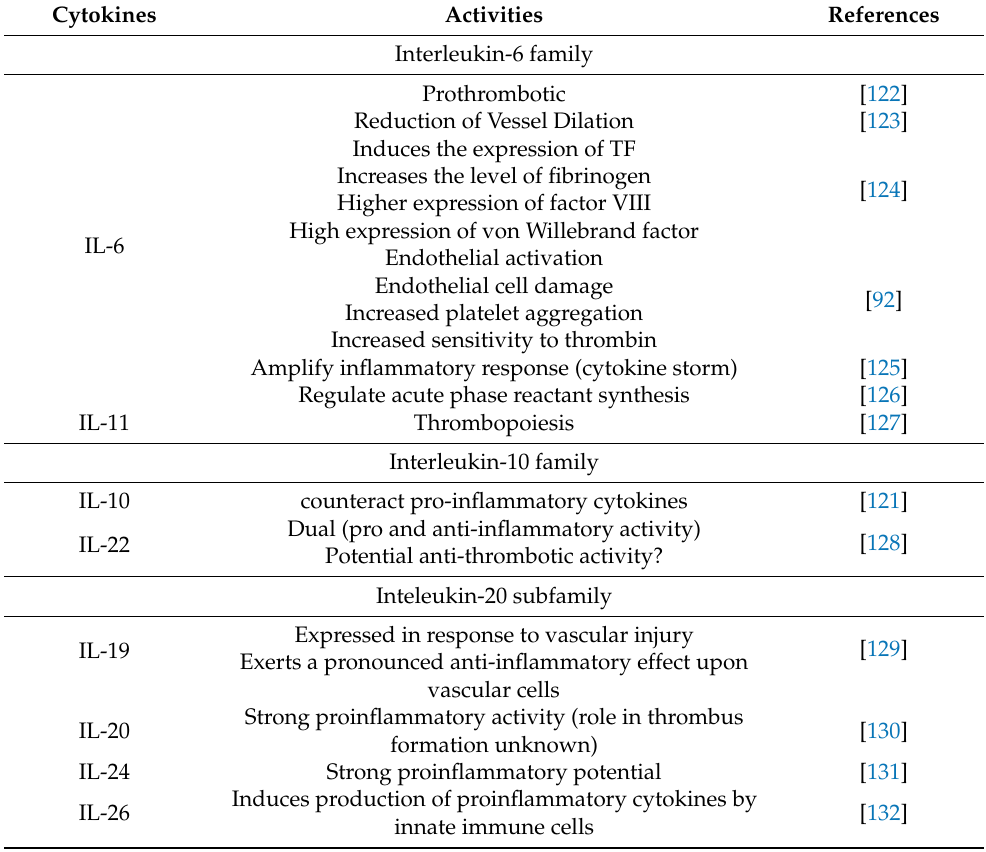
Table 1. Role of selected cytokines in thrombus